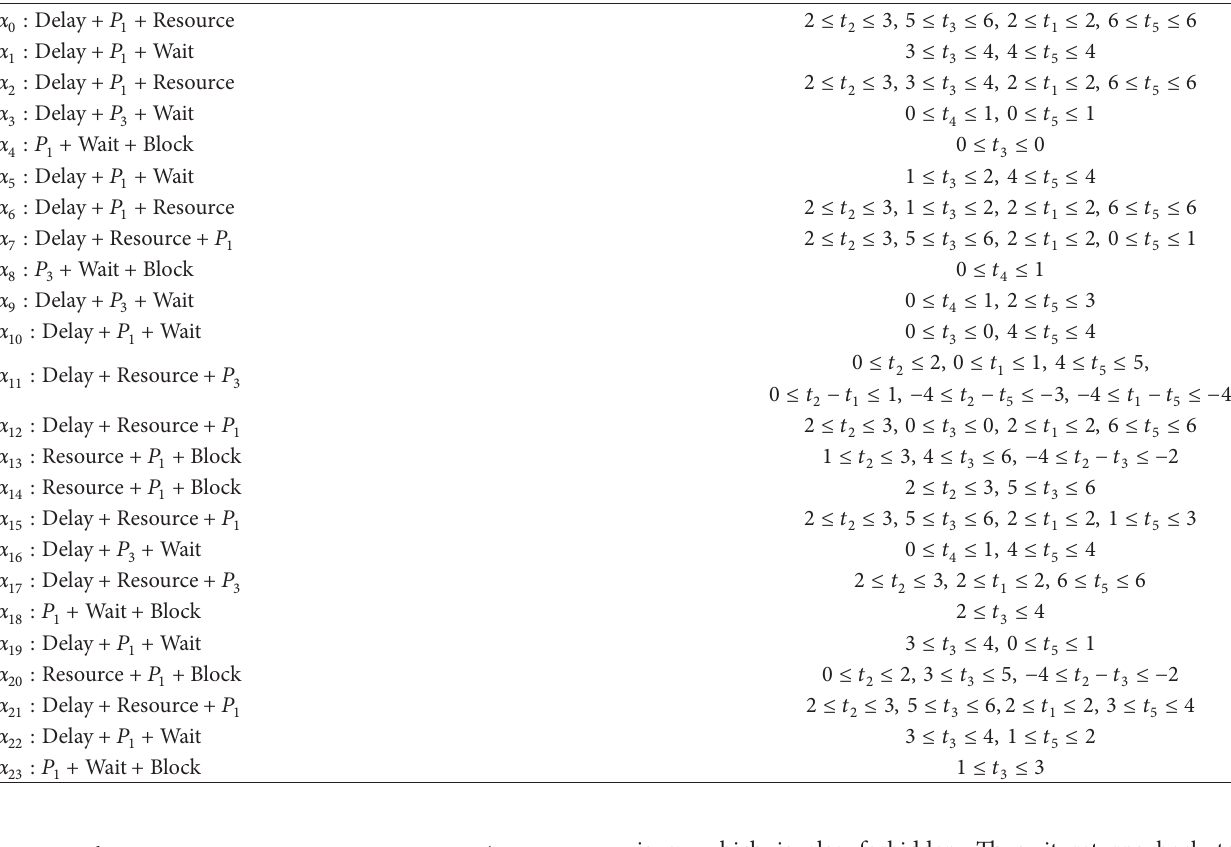
Table 2: State classes of the TPN presented at Figure 17.